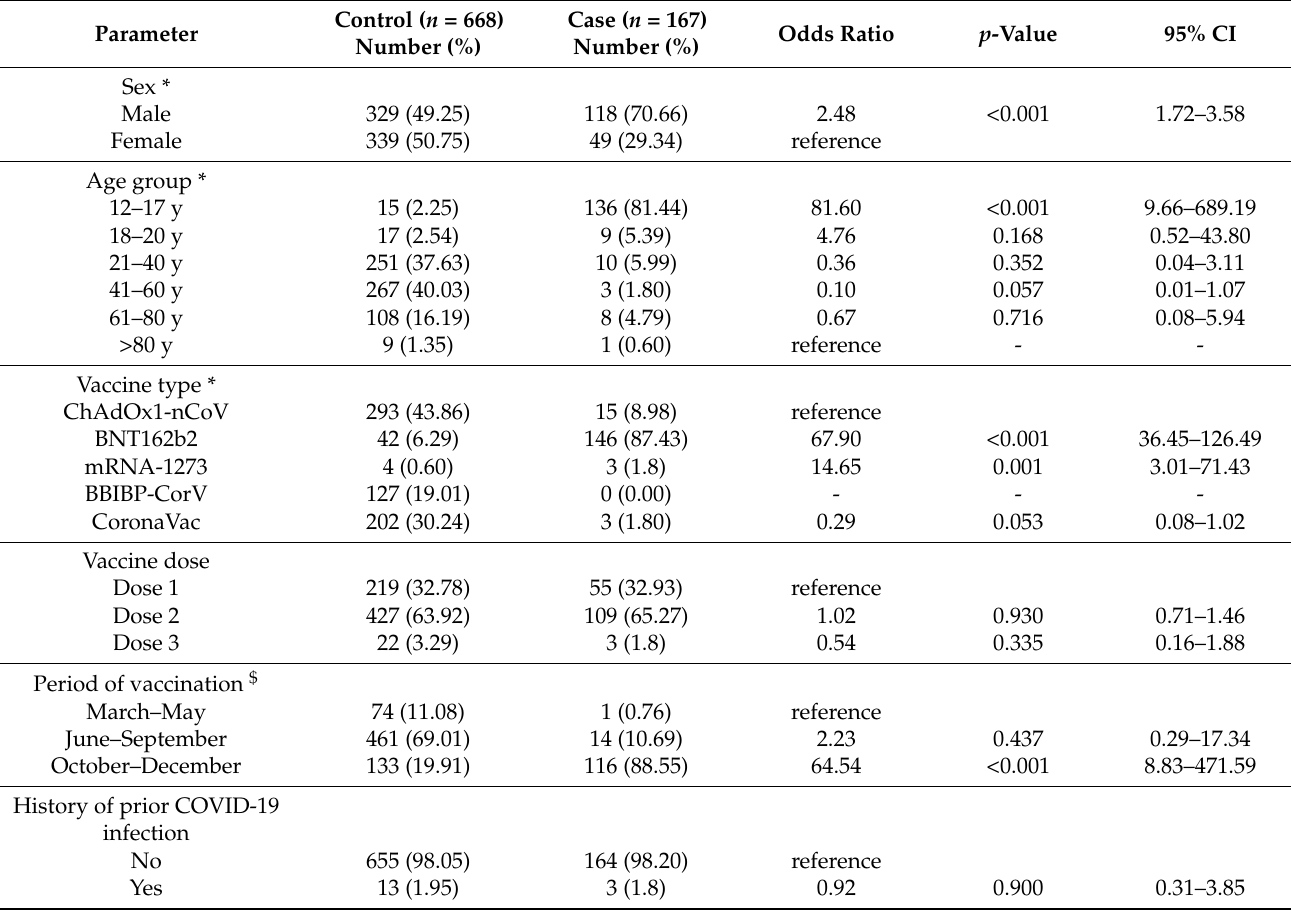
Table 4. Univariate logistic regression analysis to estimate the odds of myocarditis/pericarditis following COVID-19 vaccination.